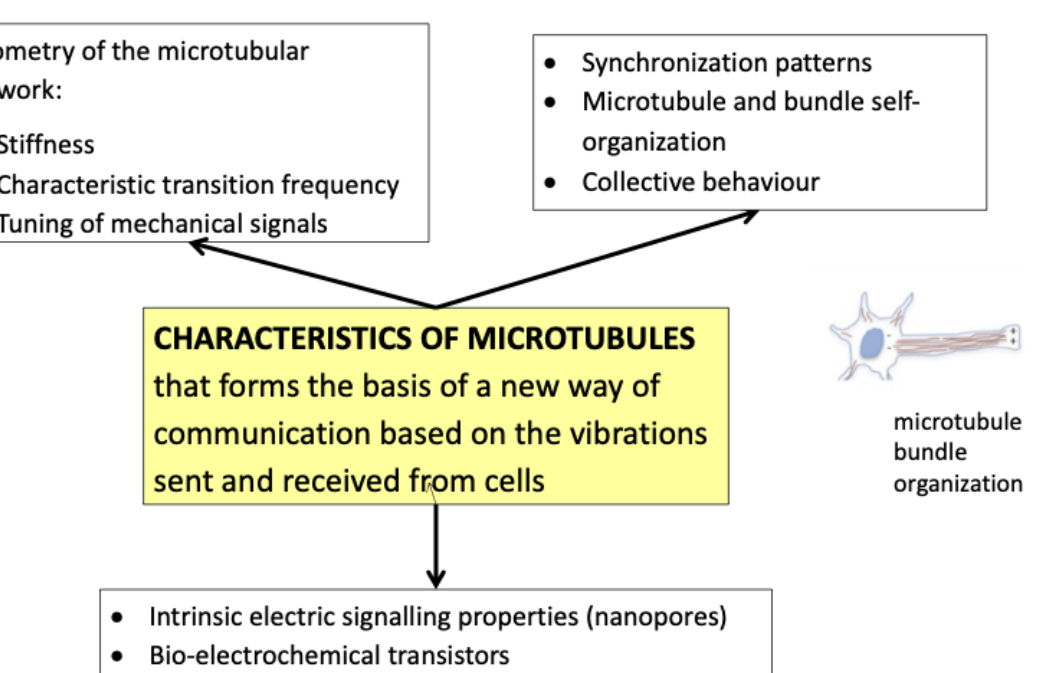
Figure 5. Proposed mechanism for cytoskeleton affecting global brain wave oscillation (adapted from Facchin et al. 2019 [49]).